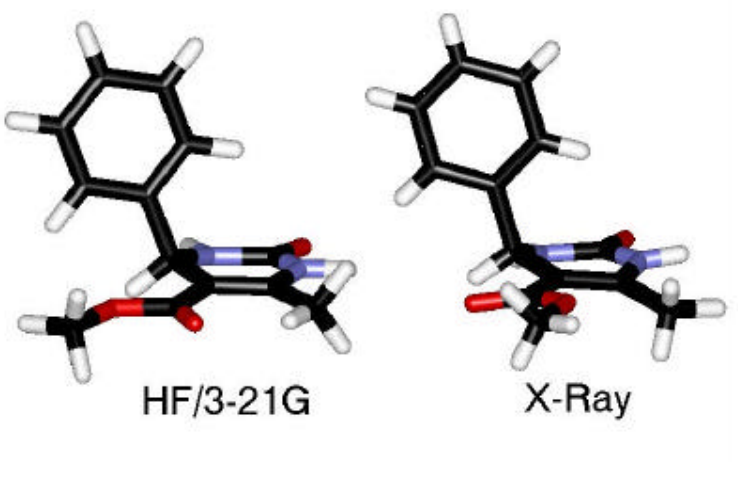
Figure 3. Comparison of an ab initio optimized geometry (HF/3-21G) and the solid state geometry of a DHPM derivative. Note the different orientation (cis versus trans) of the ester group, a result of crystal packing forces